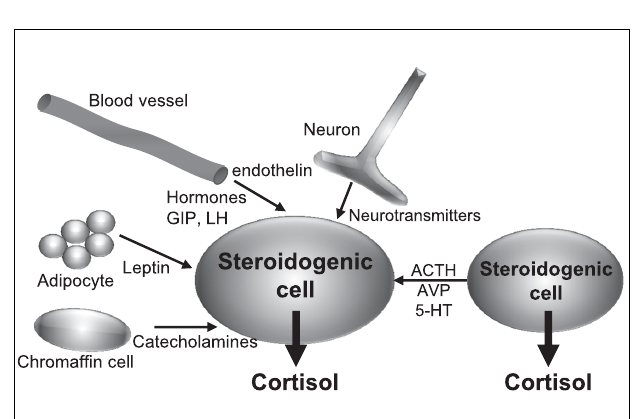
FIGURE 4 | Schematic representation of endocrine and paracrine controls of cortisol secretion in bilateral macronodular adrenal hyperplasia (BMAH) associated with Cushing’s syndrome . AVP, vasopressin; 5-HT, serotonin; GIP, glucose-dependent insulinotropic peptide; LH, luteinizing